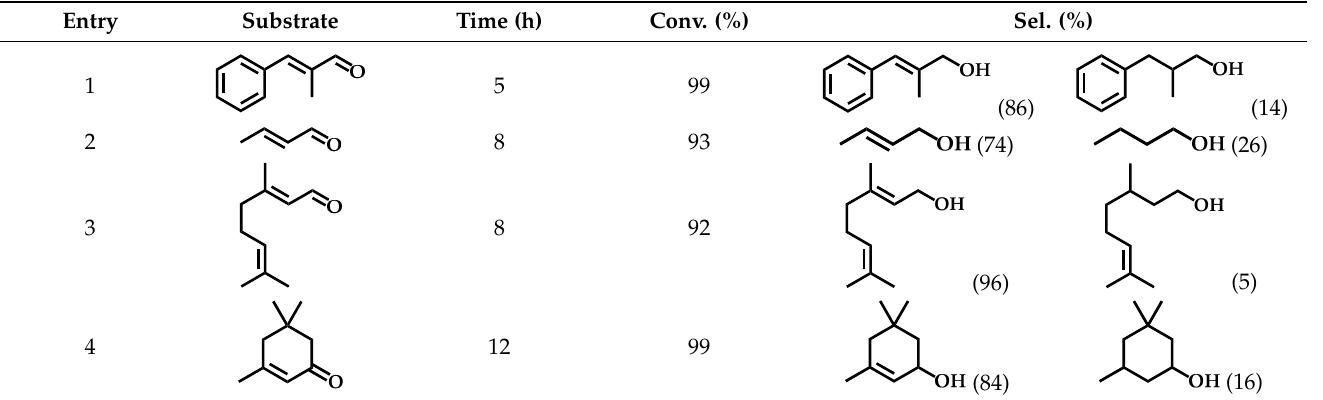
Table 4. Hydrogenation of various α , β -unsaturated aldehydes over the Co 1 Re 1 /TiO 2 catalyst.